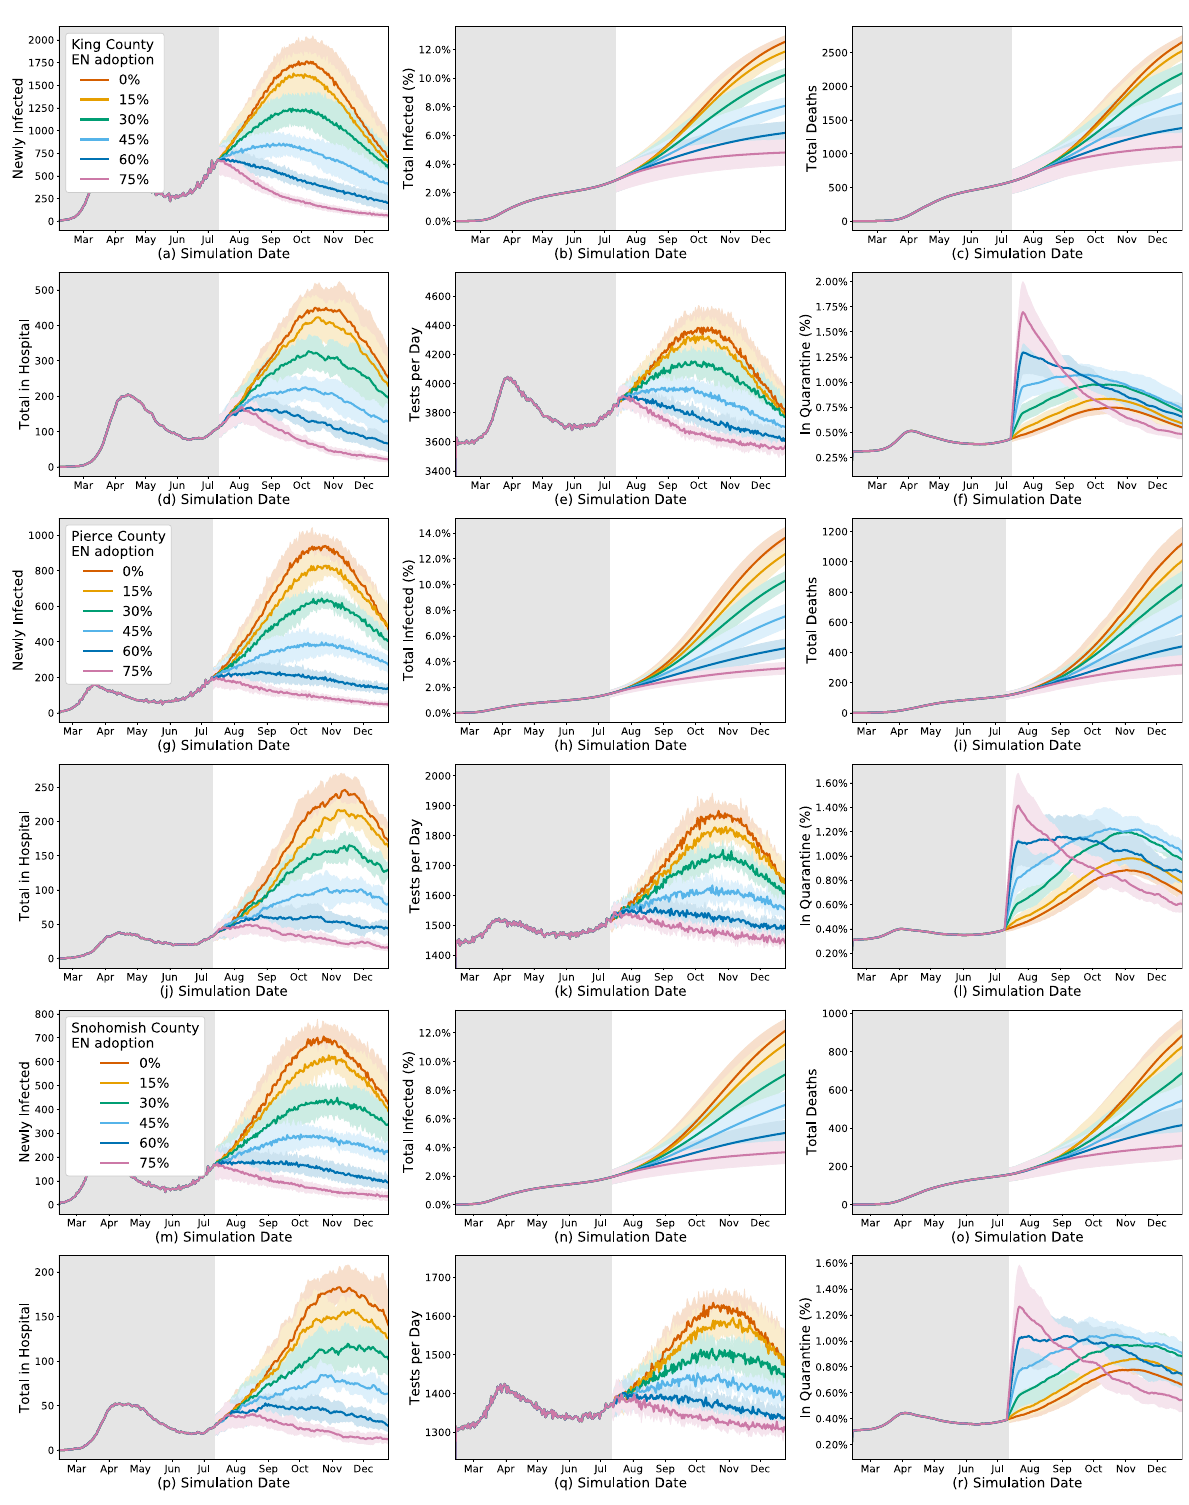
Fig. 1 Simulation time series. Simulation results for various levels of exposure noti fi cation app uptake (among the total population) during 2020, with the app being implemented on July 11, 2020 in King County ( a – f ), Pierce County ( g – l ), and Snohomish County ( m – r ). The shaded areas represent one standard deviation. Plots ( a , g , m ) are the new infections on the given day, which consistently decrease with EN adoption, although the largest variances occur in the mid-range of adoption changes. Plots ( b , h , n ) are the total infected percentage, Plots ( c , i , o ) are the total deaths, Plots ( d , j , p ) are the total in hospital, all of which naturally vary by new infections given the natural progression through the compartmental model. Plots ( e , k , q ) are the total number of tests performed per day, which also varies by new infections as tests are only performed on symptoms, not on trace, so they correlate with the proportion of newly infected individuals who eventually show symptoms. Plots ( f , l , r ) are the percent of people in quarantine at that time step, which varies non-linearly with the infection rates due to increased quarantines from increased contact tracing but decreased quarantines with decreasing infection